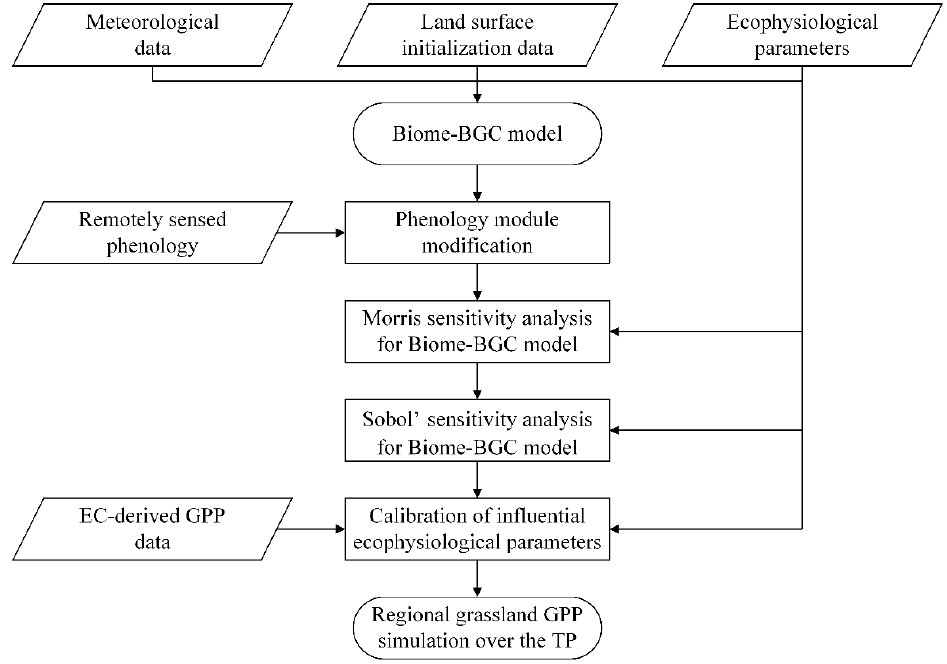
Figure 2. The flow chart of this study. EC, eddy covariance; GPP, gross primary productivity.